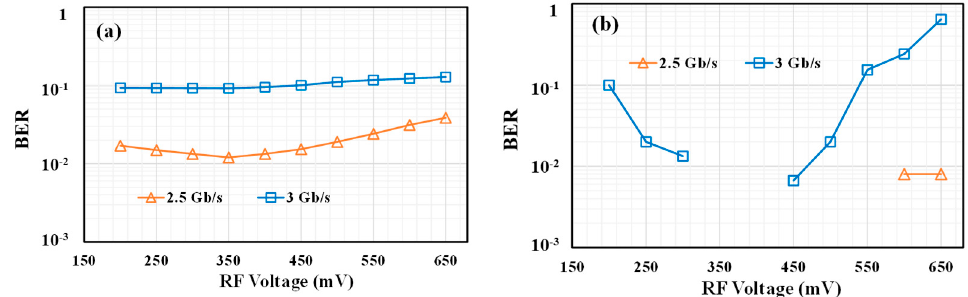
Figure 5. BER vs. amplitude voltage of RF OOK signal by using ( a ) symbol by symbol (SBS) detection and ( b ) MLSE detection, the LD bias current is 35 mA and received optical power is 0.6 mW.